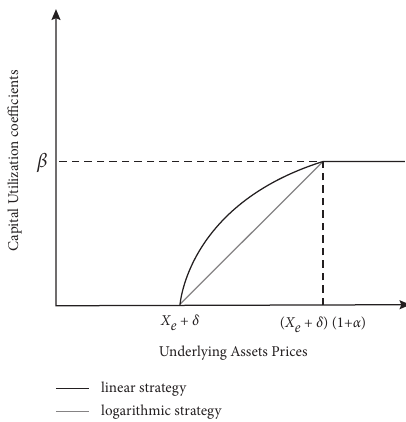
Figure 2: Capital utilization coefficients of the logarithmic strategy vs. the linear